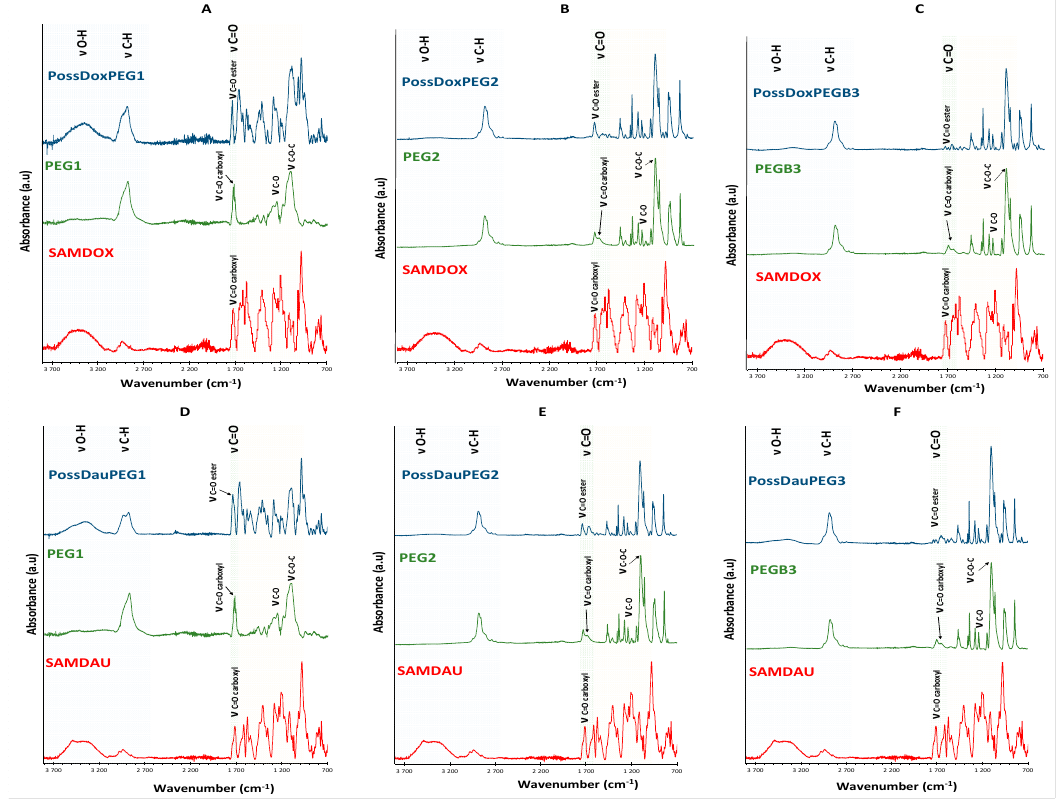
Figure 9. Fourier transform infrared spectra of conjugates 4 – 9 compared with those of antracyclines and PEGs. Blue color—range 2700–3700 cm − 1 ( ν O-H , ν C-H ); green color—range 1700–1750 cm − 1 ( ν C=O , ester). ( A ) PossDoxPEG1 ( 4 ); ( B ) PossDoxPEG2 ( 5 ); ( C ) PossDoxPEGB3 ( 6 ); ( D ) PossDauPEG1 ( 7 ); ( E ) PossDauPEG2 ( 8 ); ( F ) PossDauPEGB3 ( 9 ). Conjugate 4 (Figure 10A) exhibits the new absorption band at 1732 cm − 1 ( ν C=O , ester bond), clearly indicating the formation of ester bond between SAMDOX/PEG1 and POSS(OH) 32 . There is no absorption in the spectrum indicating the presence of unreacted carboxyl groups (SAMDOX 1721 cm − 1 ( ν C=O carboxylic bond) and PEG1 1722 cm − 1 ( ν C=O carboxylic bond)). The same characteristic absorption is also evident for conjugate 6 (Fig- ure 10C). The spectrum of conjugate 5 (Figure 10B) is more difficult to interpret as PEG2 also has an ester linkage. We can assume that the ester bond in conjugate 5 has been formed, as shown by the shift of the ν C=O PEG2 (ester bond) absorption from 1732 cm − 1 to 1734 cm − 1 . There is no absorption in the spectrum that would indicate the presence of unreacted car- boxyl groups. The same conclusion can be drawn from the spectrum of conjugate 8 (Figure 10E). In contrast, in the spectrum of conjugate 7 (Figure 10D), the absorption at 1732 cm − 1 ( ν C=O ester bond), indicating the formation of ester bond, also appears, but there are still unreacted carboxyl groups from SAMDAU or PEG1 as shown by widening of the band at 1732 cm − 1 . The situation is similar for conjugate 9 (Figure 10F), however, here there is a clear absorption at 1708 cm − 1 indicating unreacted –COOH moieties from SAMDAU or PEGB3.